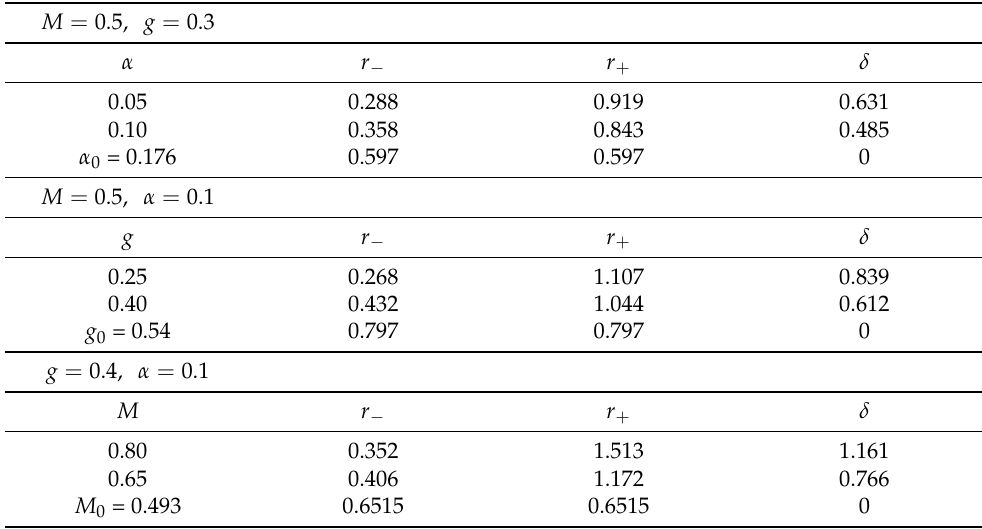
Table 1. Cauchy horizon radius ( r − ), the event horizon radius ( r + ) and δ = r + − r − of 4 D nonsingular EGB black hole for different values of